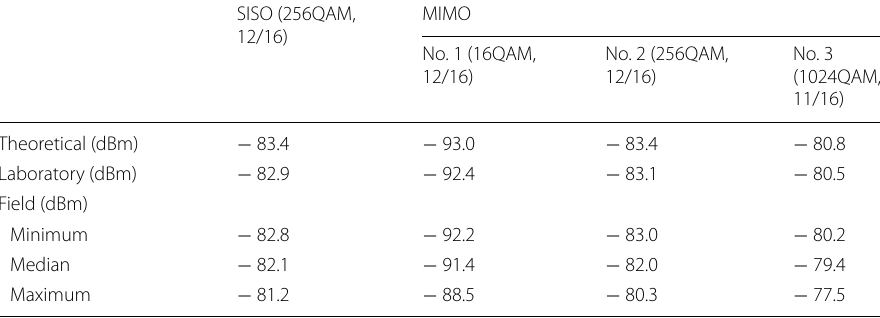
Table 6 Required received power in field experiments